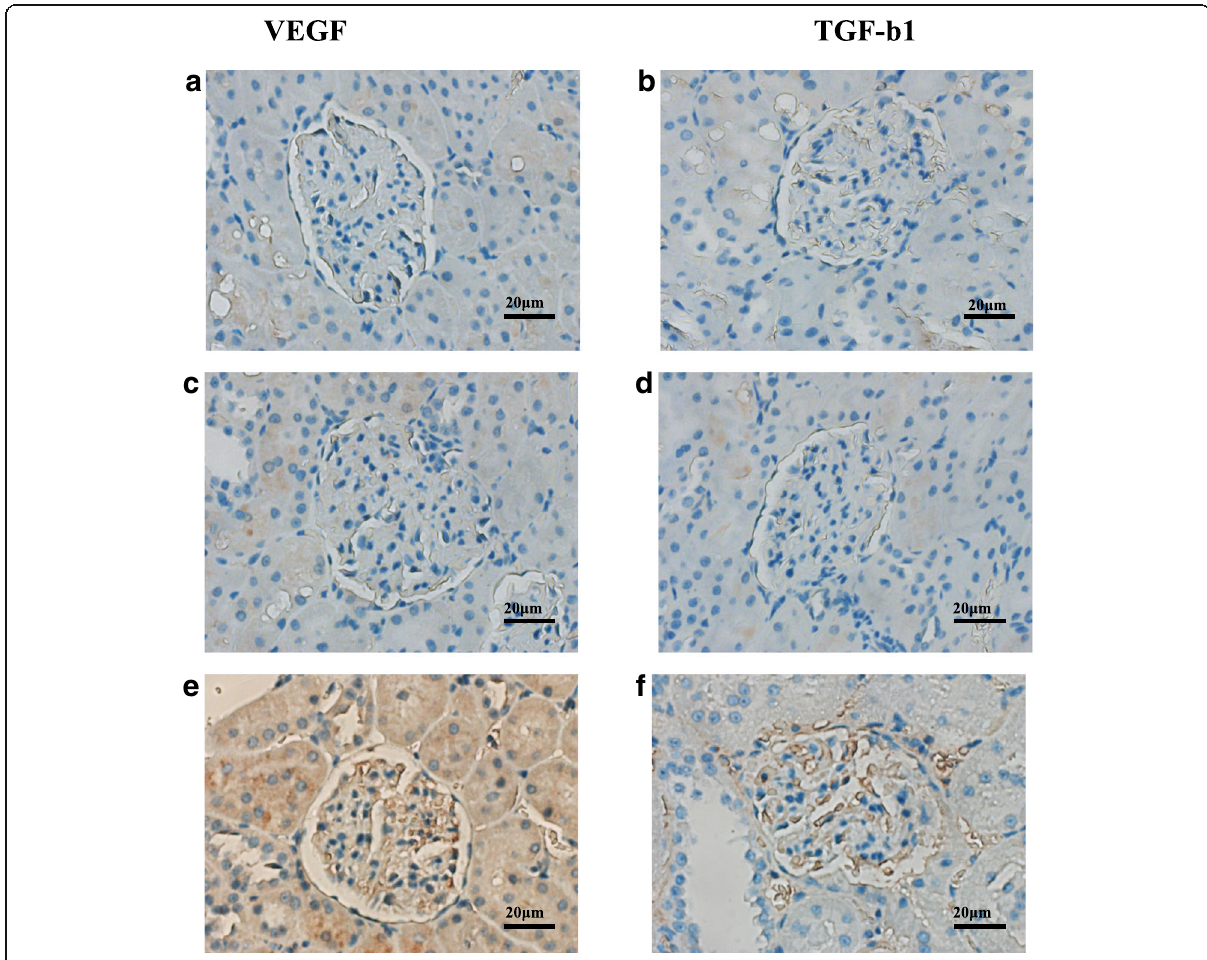
Fig. 9 The negative controls of VEGF ( a ) and TGF- β 1 ( b ) and pre-adsorbtion controls of VEGF ( c ) and TGF- β 1 ( d ) showed a complete abolishment of specific signals for all antibodies. Positive contols for VEGF ( e ) and TGF- β 1 ( f ) staining showed a apecific staining partterns in the vascular epithilial cells for VEGF and in the stroma cells for TGF- β